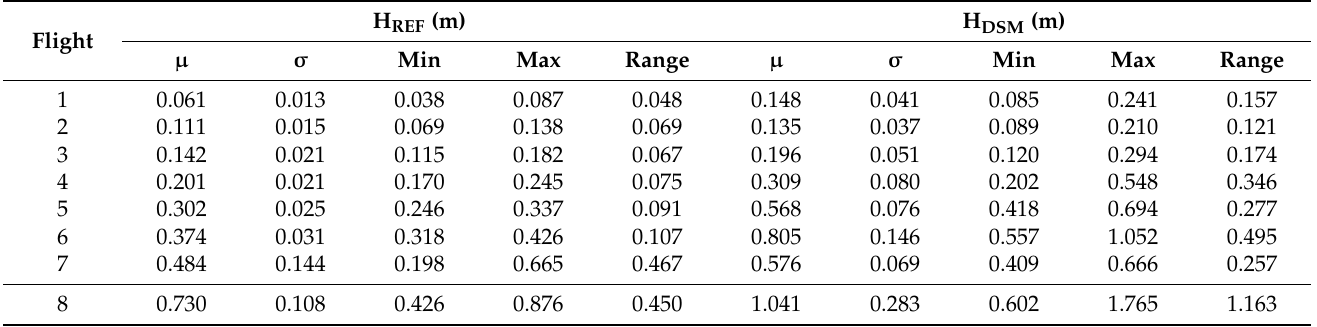
Table 3. Descriptive statistics of H DSM and H REF for each flight mission and in-field inspection.